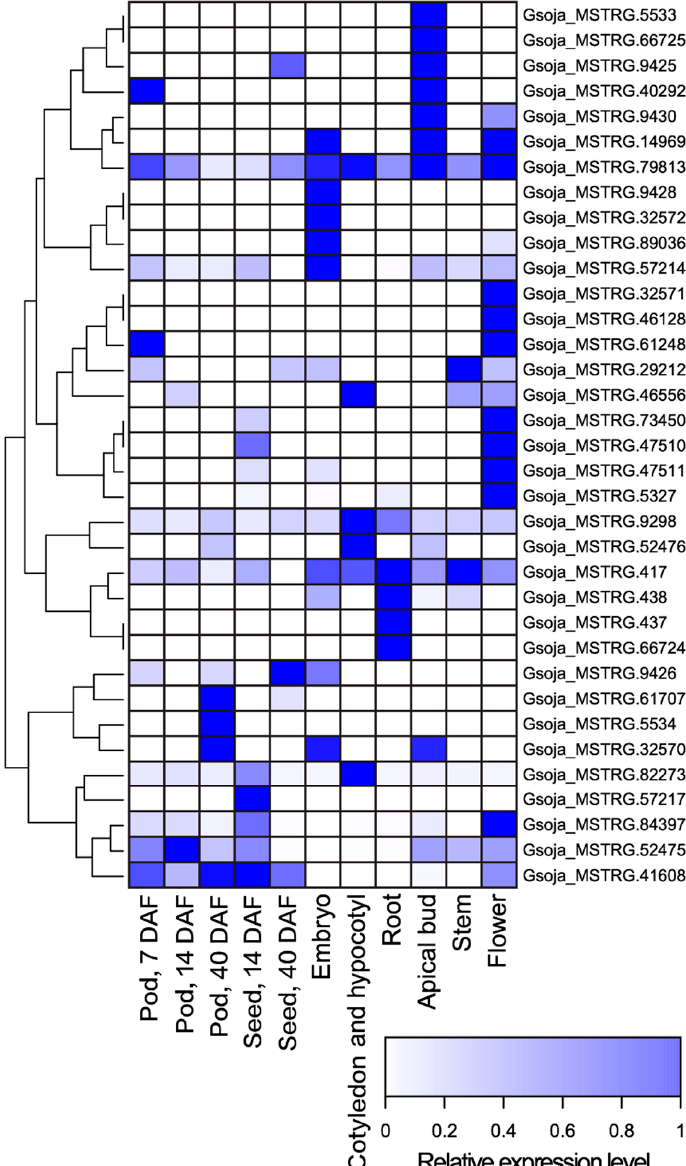
Figure 1. A heatmap of the predicted relative expression levels of MATE antisense transcripts identified from strand-specific RNA-seq datasets of pod (7 DAF), pod (14 DAF), pod (40 DAF), seed (14 DAF), seed (40 DAF), embryo, cotyledon and hypocotyl, root, apical bud, stem, and flower of soybean accession W05 (Table S1)